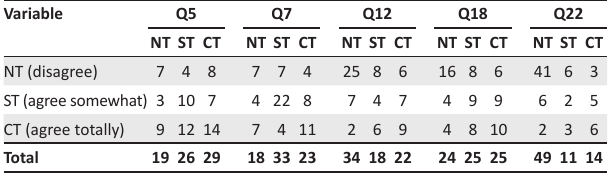
TABLE 3a: Comparison of conduct domain scores for adolescent–caregiver pairs.